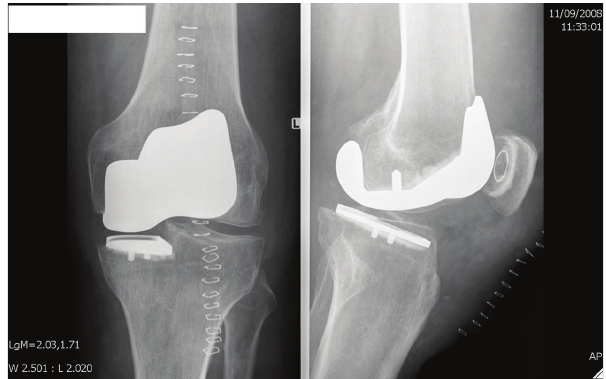
Figure 1: Anteroposterior and profile view X-rays of the knee. administered. Further X-rays revealed osteochondritis disse- cans of the medial condyle (Figure 1). The medial femoral condyle was found to have grade 4 cartilage defects cov- ering 70% of the surface on arthroscopic evaluation. The patellofemoral compartment had grade 2-3 cartilage defects.